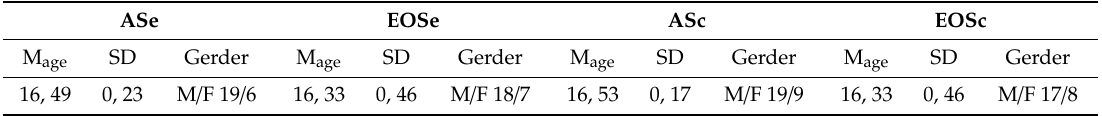
Table 1. Subdivision of the